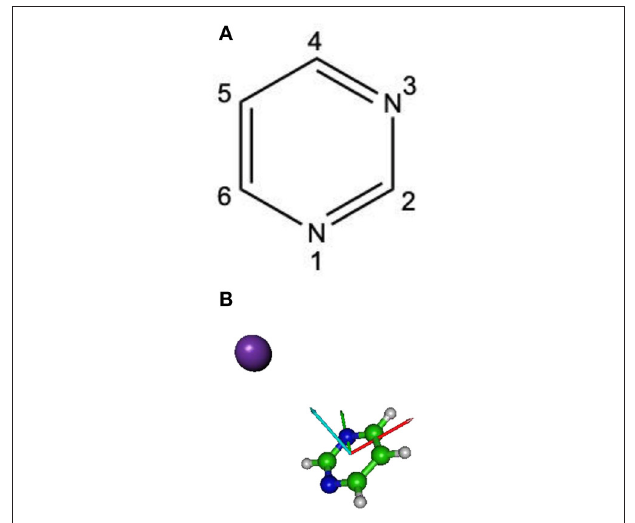
FIGURE 1 | (A) Molecular structure of pyrimidine (Pyr); (B) orientation of the Pyrimidine + K collisional system; x, red; y, green, z,